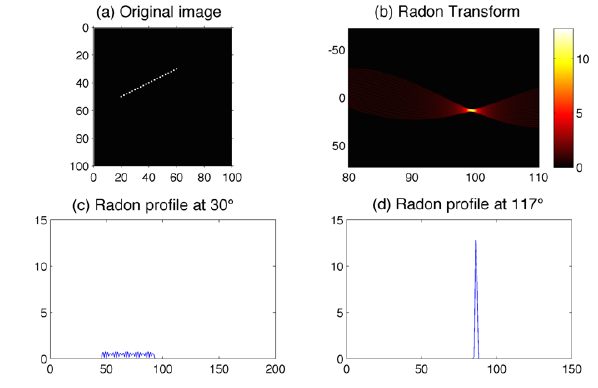
Figure 5. An example of RT to detect linear feature.